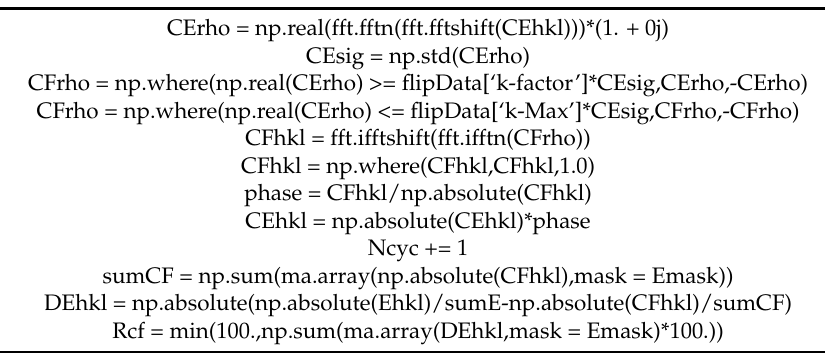
DEhkl = np.absolute(np.absolute(Ehkl)/sumE-np.absolute(CFhkl)/sumCF) Rcf = min(100.,np.sum(ma.array(DEhkl,mask =